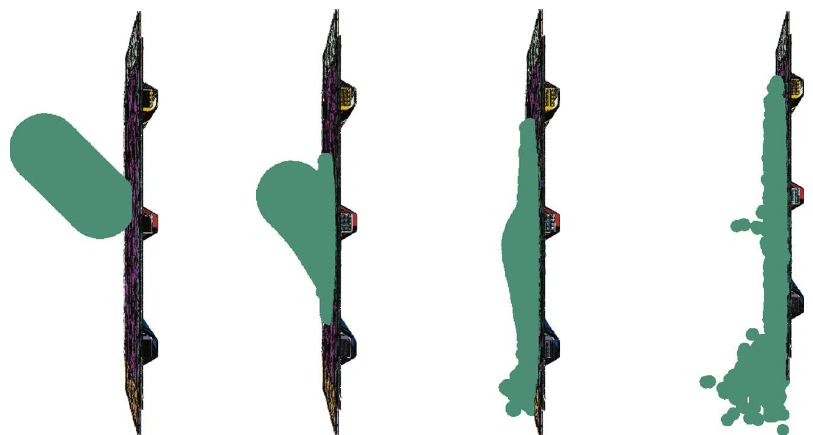
Figure 19: Morphology of the bird body at di ff erent moments of 45 ° .